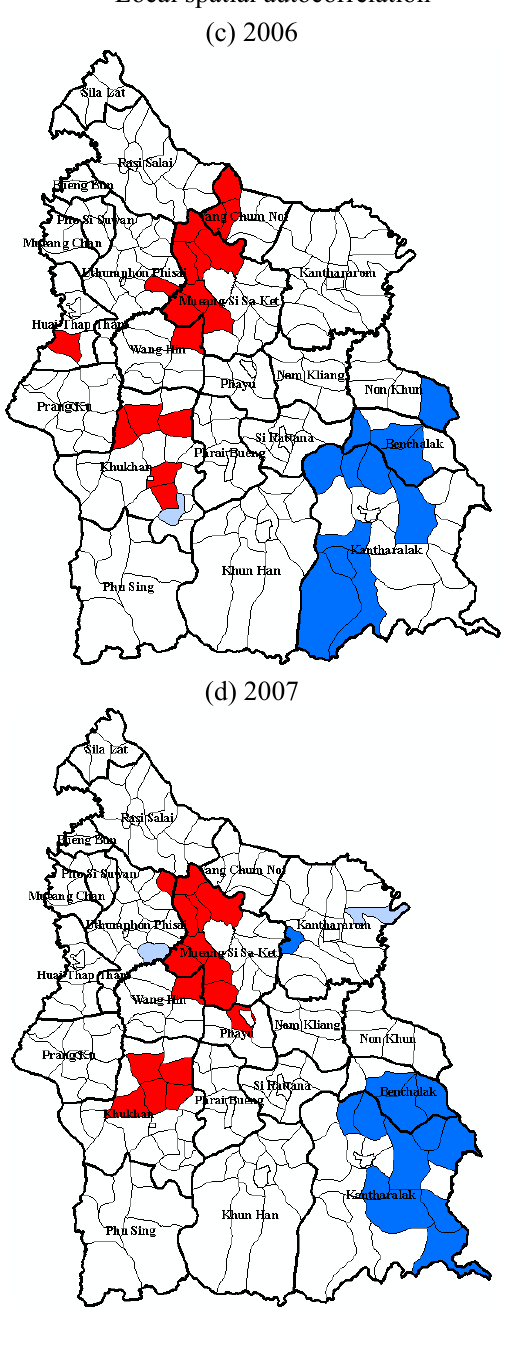
Figure 5. Cont. Figure 5.